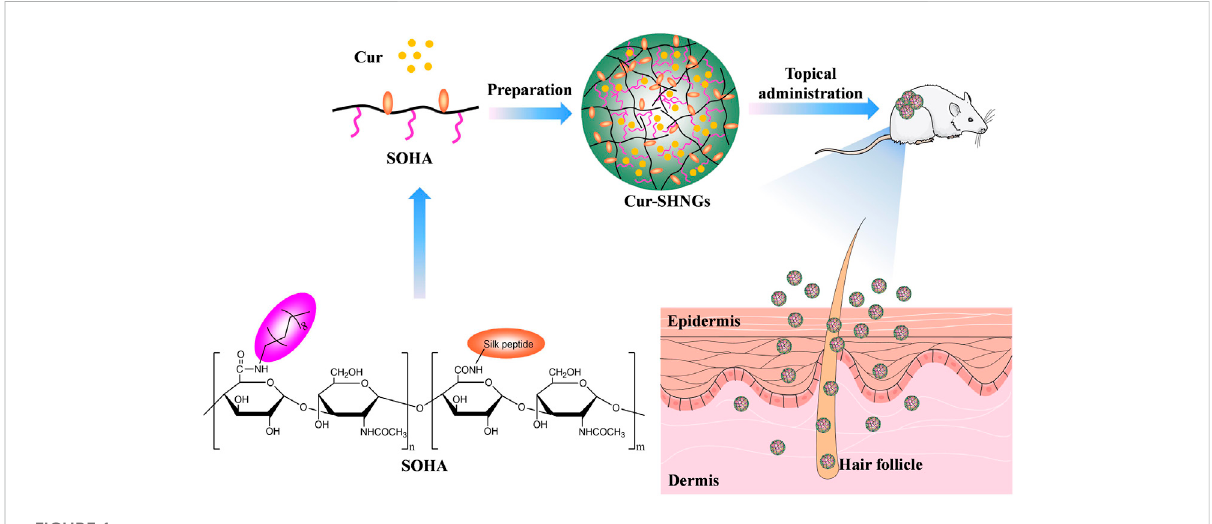
FIGURE 1 Schematic illustration of the Cur-loaded nanogels (Cur-SHNGs) based on SOHA conjugate for the enhancement of the topical administration of